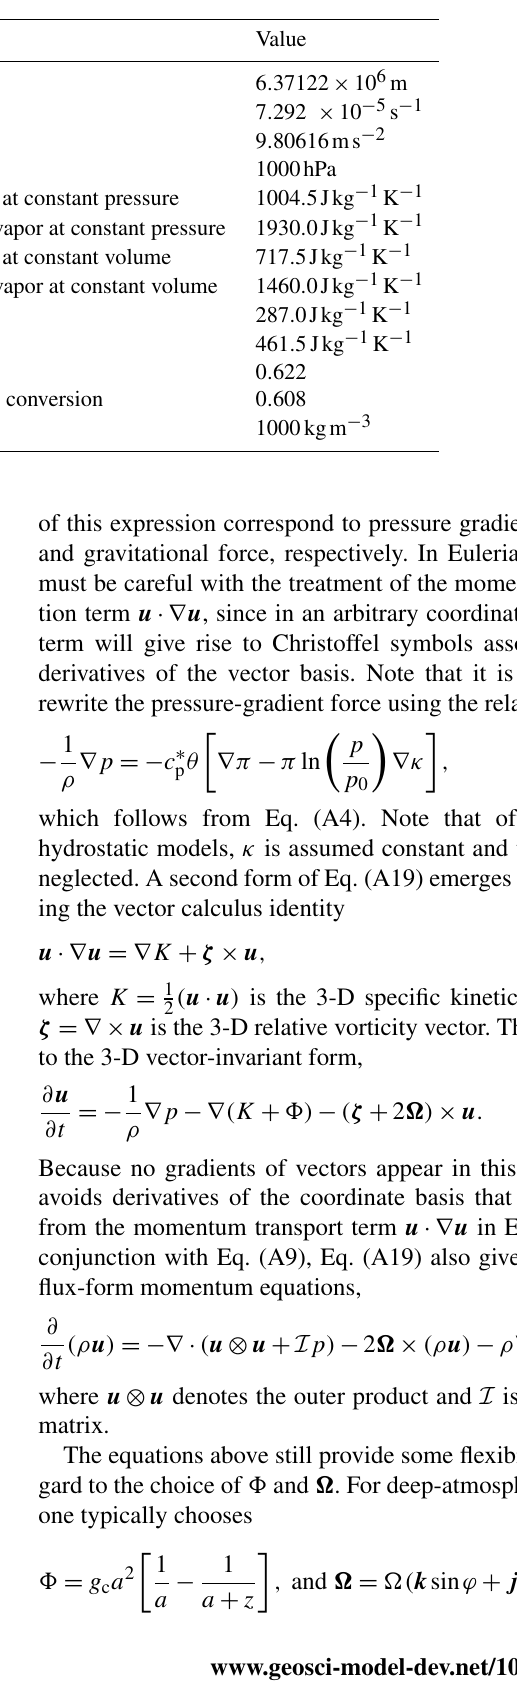
Table A1. A list of physical constants used in this